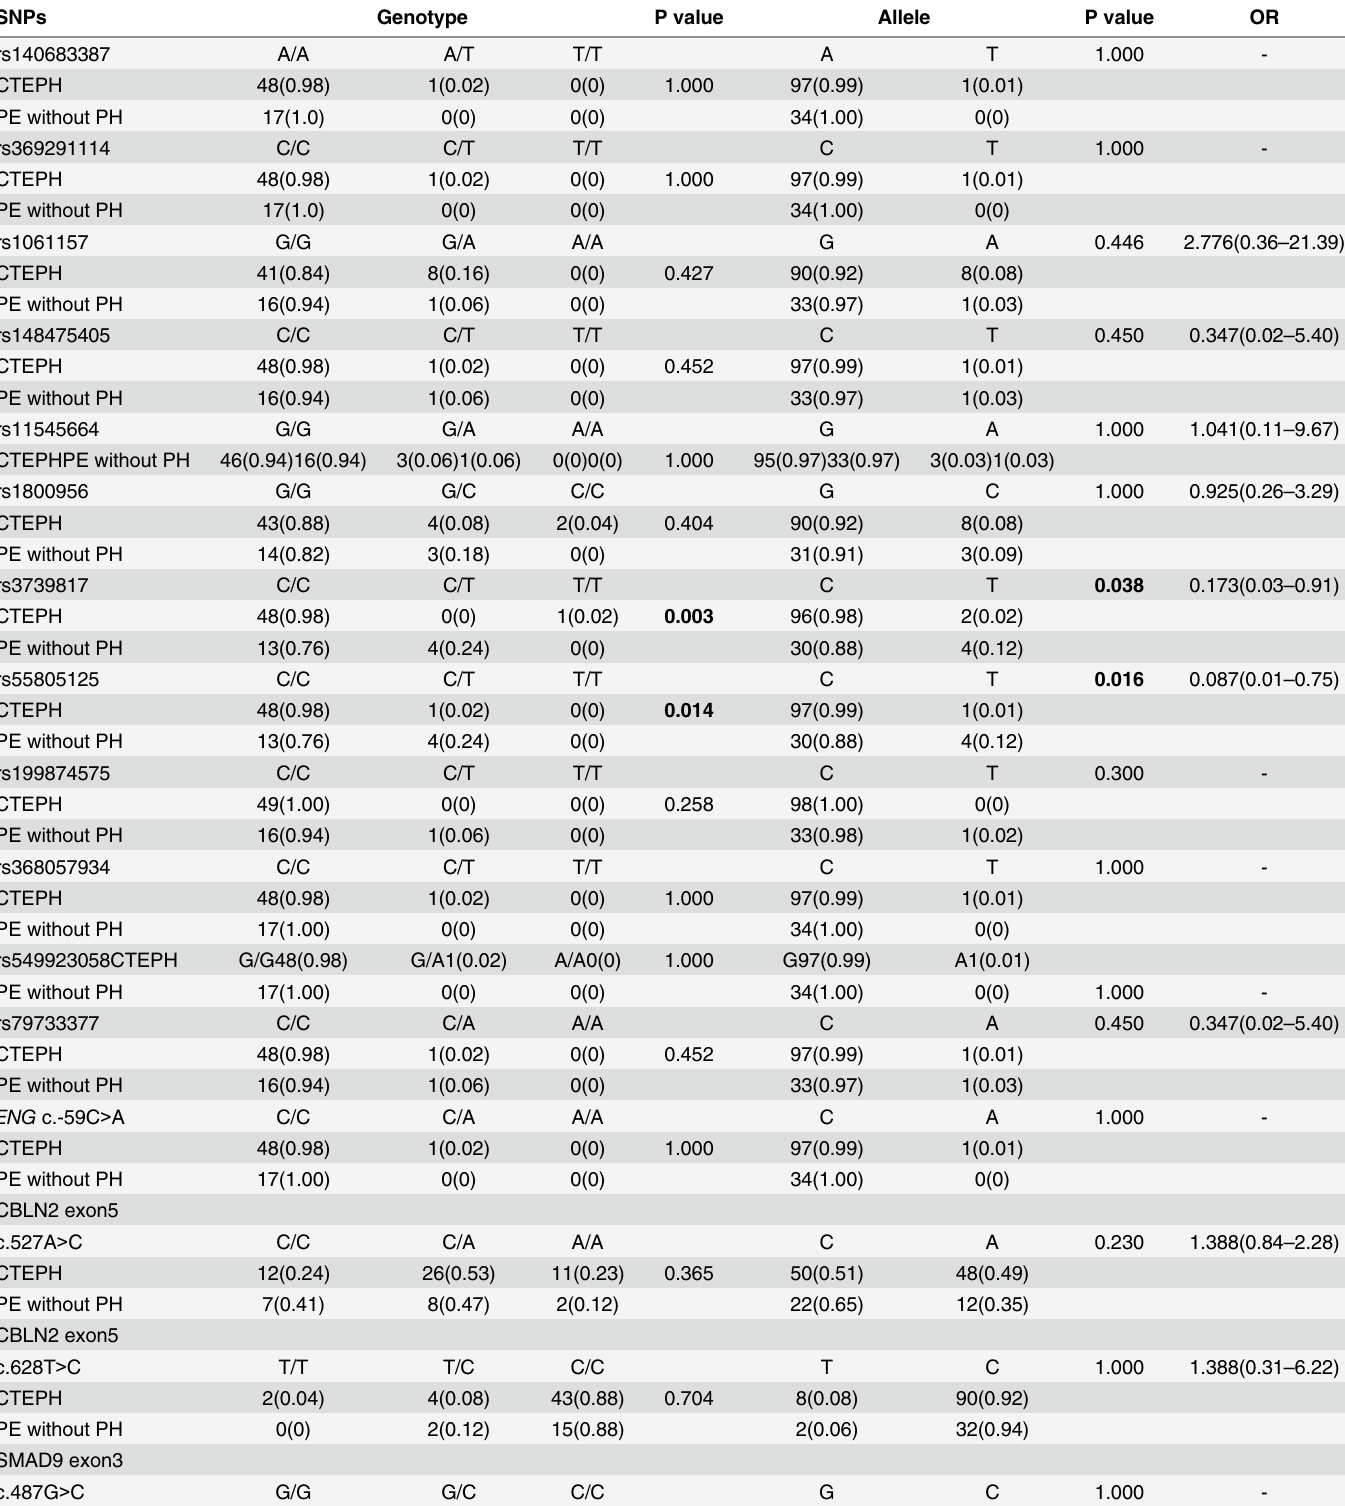
Table 6. Outline of